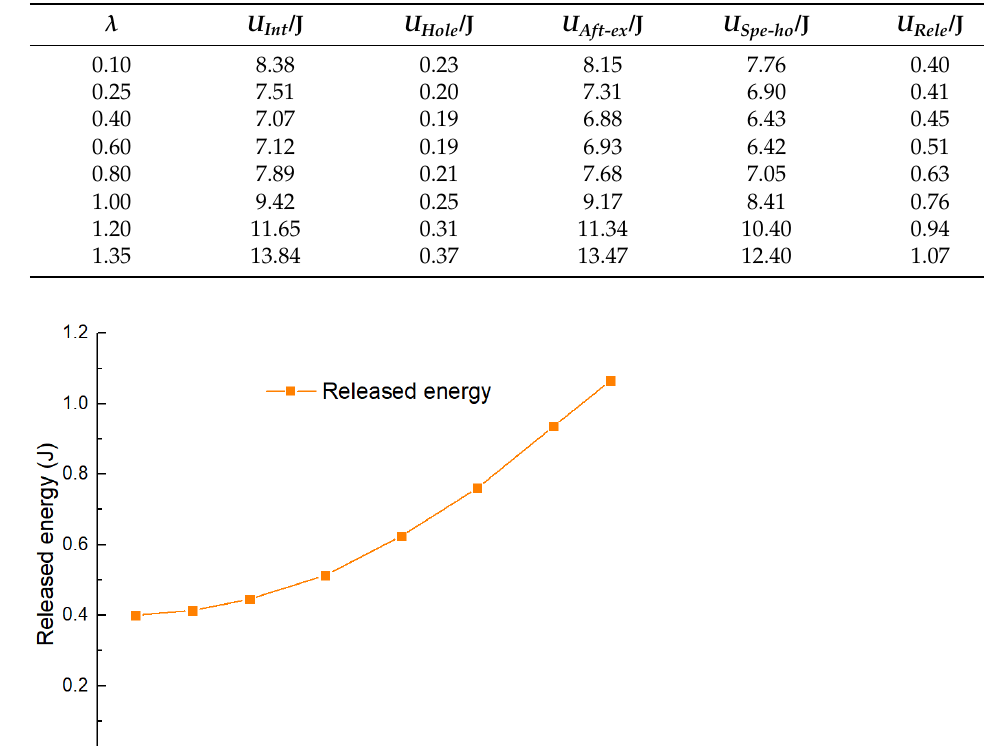
Table 8. The strain energy of each part under different lateral pressure coefficients λ .